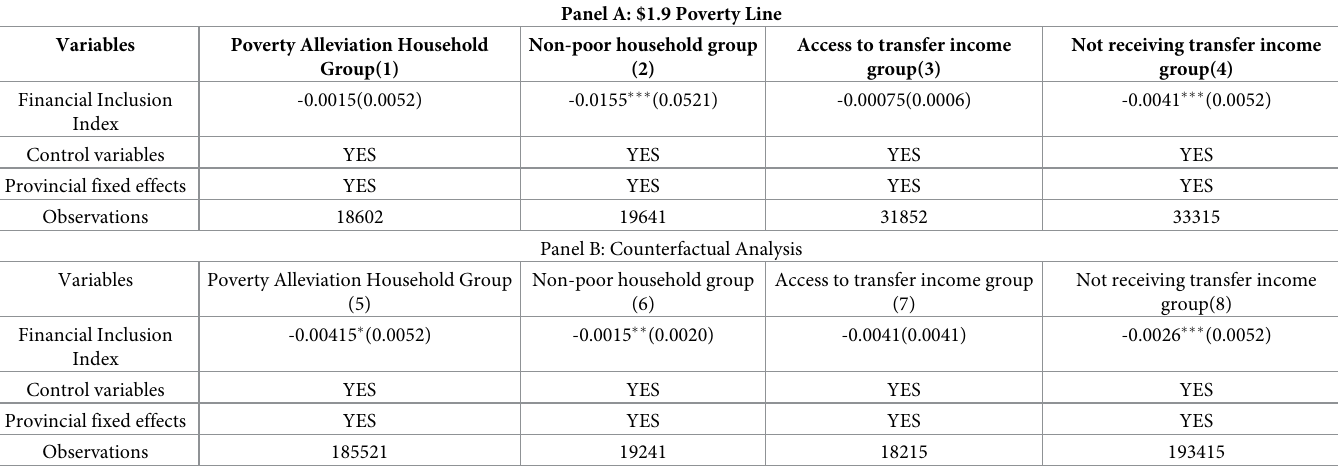
Table 9. Financial inclusion and precision poverty reduction (2SLS estimates).